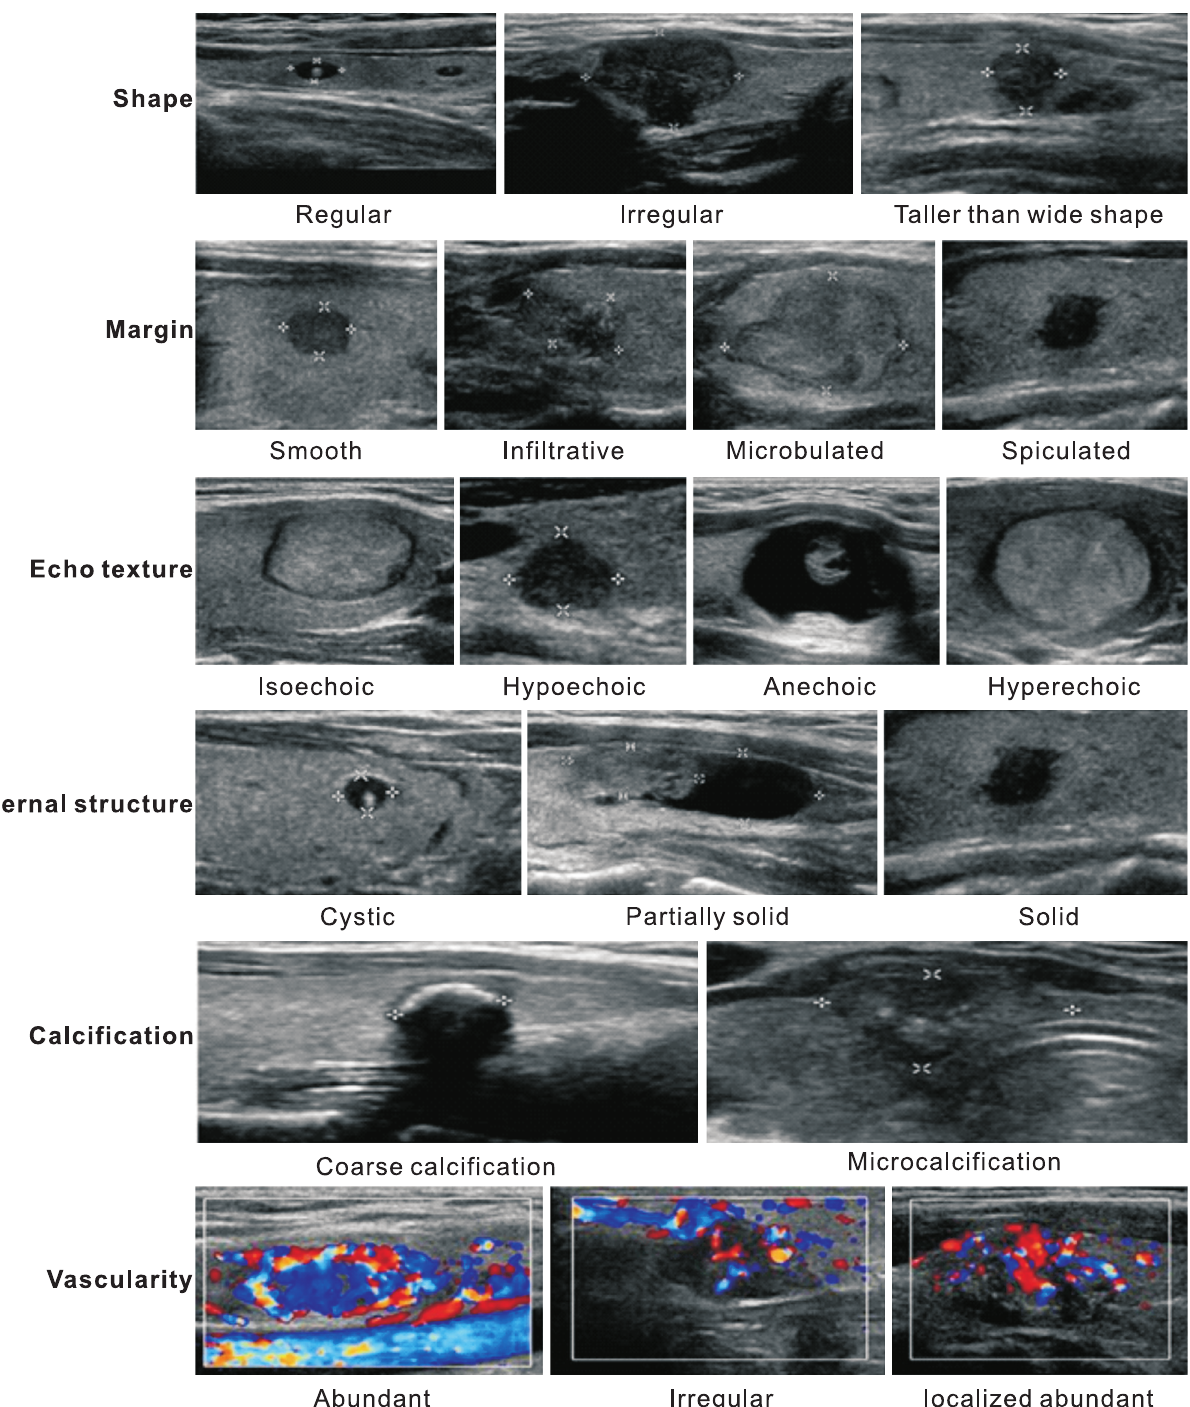
Figure 1 US features of thyroid